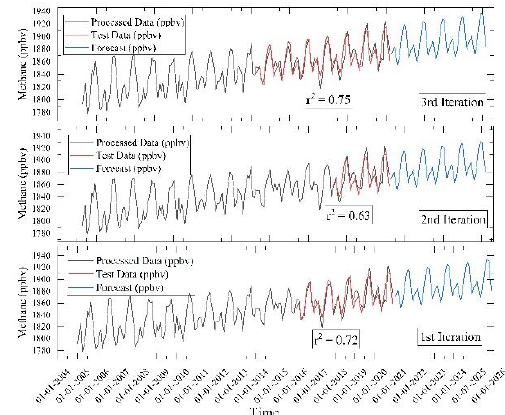
Figure 5: Forecast of Methane from year 2021 to 2025 using three iterations according to different training periods. First iteration uses 10 years data for training and 5 years as test. Second iteration uses 12 years data for training and 3 years as test. Third iteration uses 8 years data as training and 7 years as